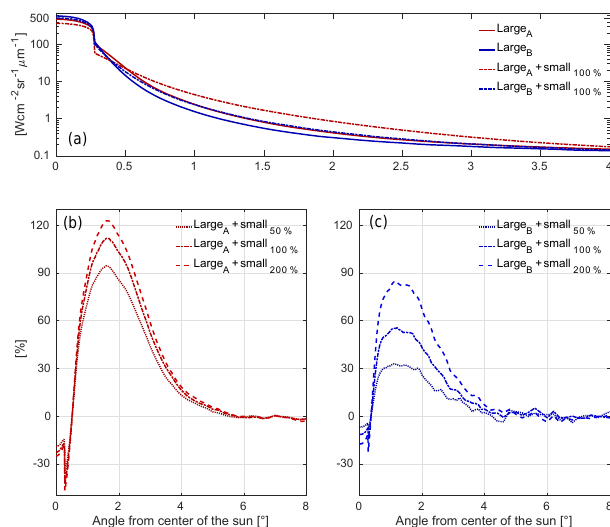
Figure 9. (a) Impact of the concentration of small ice crystals on the disk and circumsolar radiances. The simulations are made with the large A and large B distributions of large ice crystals including 0– 200% of the measured concentration of small ice crystals assumed to be columns. (b, c) Relative differences to the case with no small ice crystals. In these simulations ice crystals are severely rough, τ a = 0 . 09, and τ c = 1 .